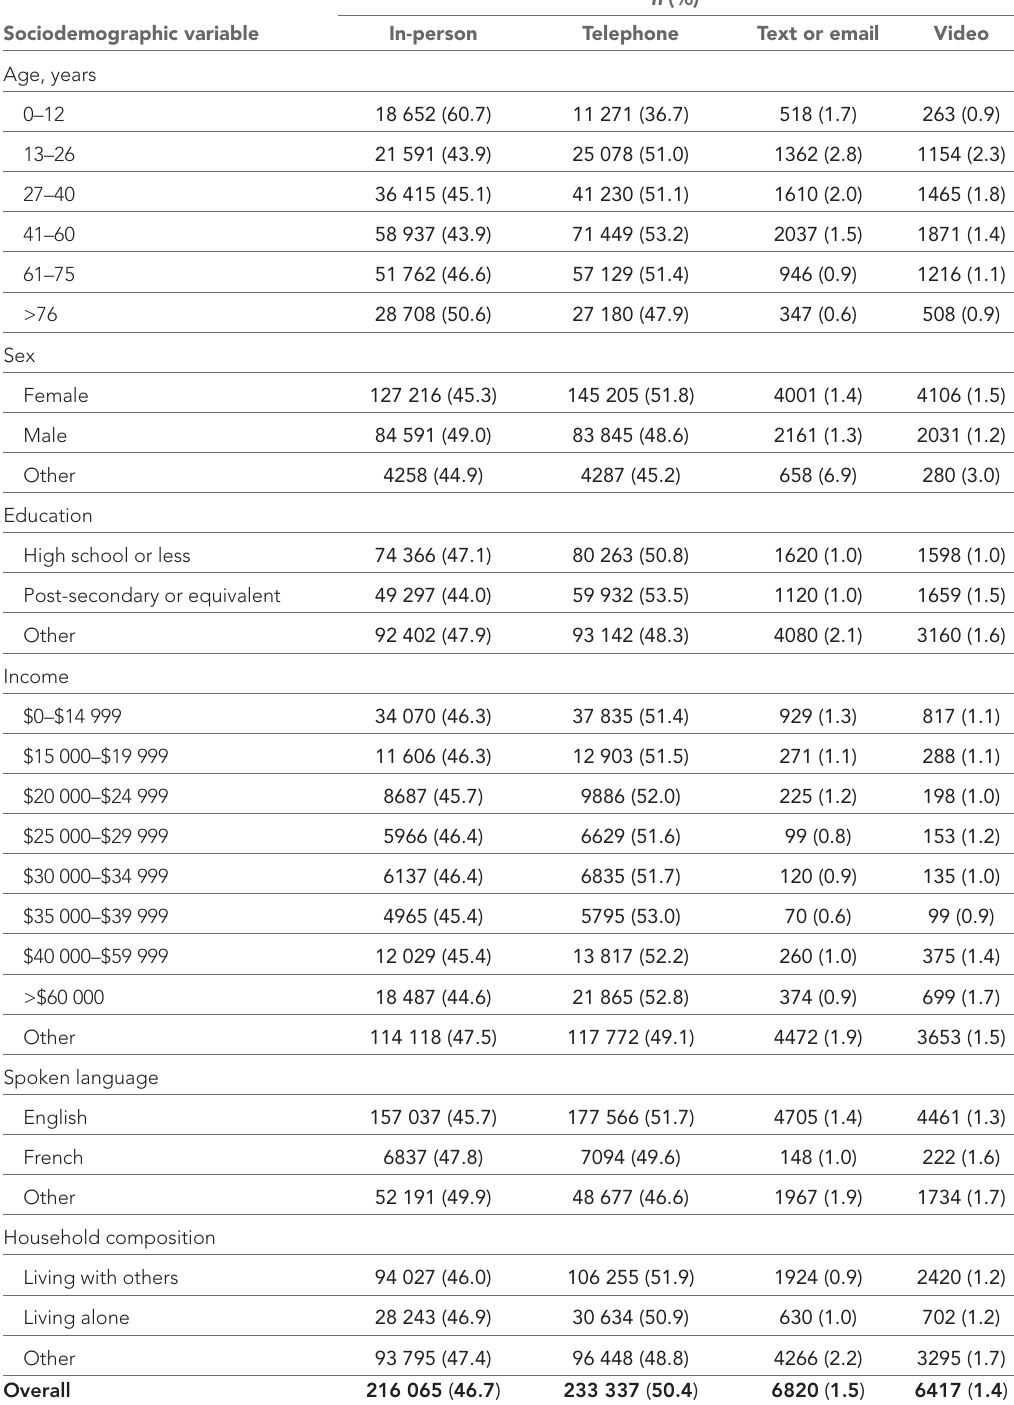
Table 4 Patient characteristics by visit